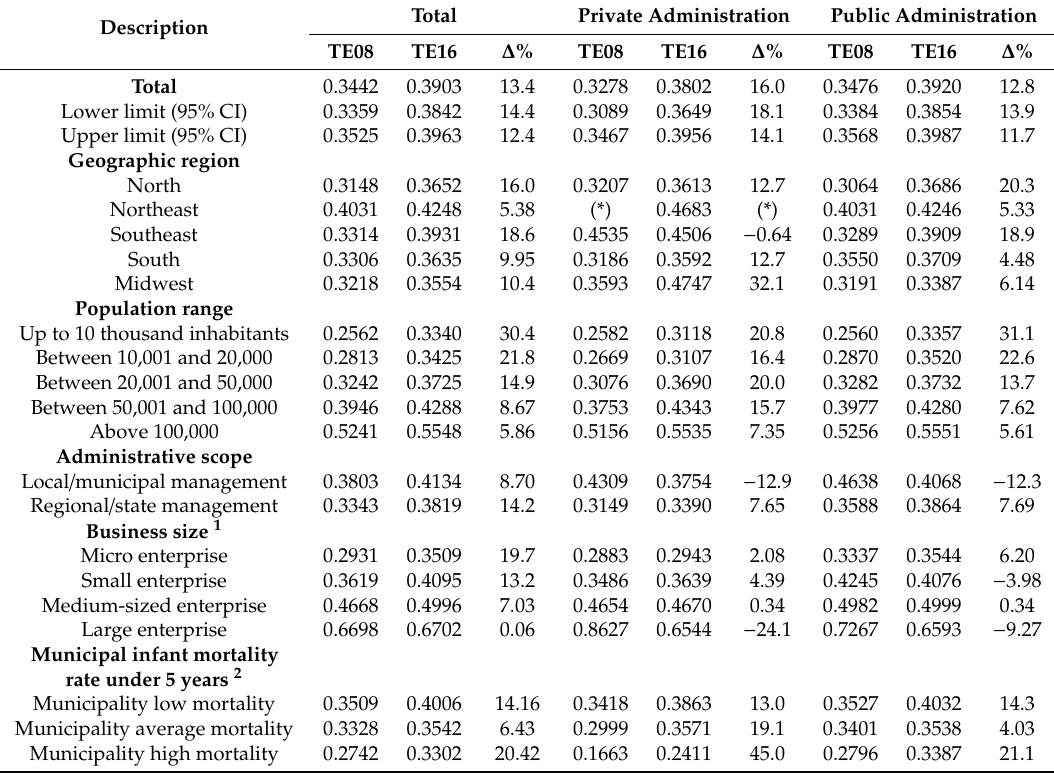
Table 3. Description of TE scores by administrative network of BSU (basic sanitation unit) using the M-DEA